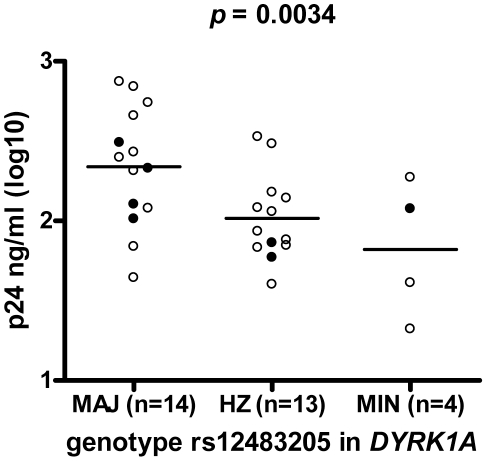
Significant association between rs12483205 and in vitro replication of HIV-1 in macrophages derived from an independent group of 31 healthy blood donors.The negative association between the rs12483205 minor allele and Gag p24 levels in MDM culture supernatant 14 days after inoculation with HIV-1, was found to match with the results from the genome-wide association study. Open circles represent results from donors with the CCR5 Δ32 wild-type genotype, filled circles from donors with the CCR5 wt/Δ32 heterozygous genotype. MAJ, homozygous for the major allele; HZ, heterozygote; MIN, homozygous for the minor allele.